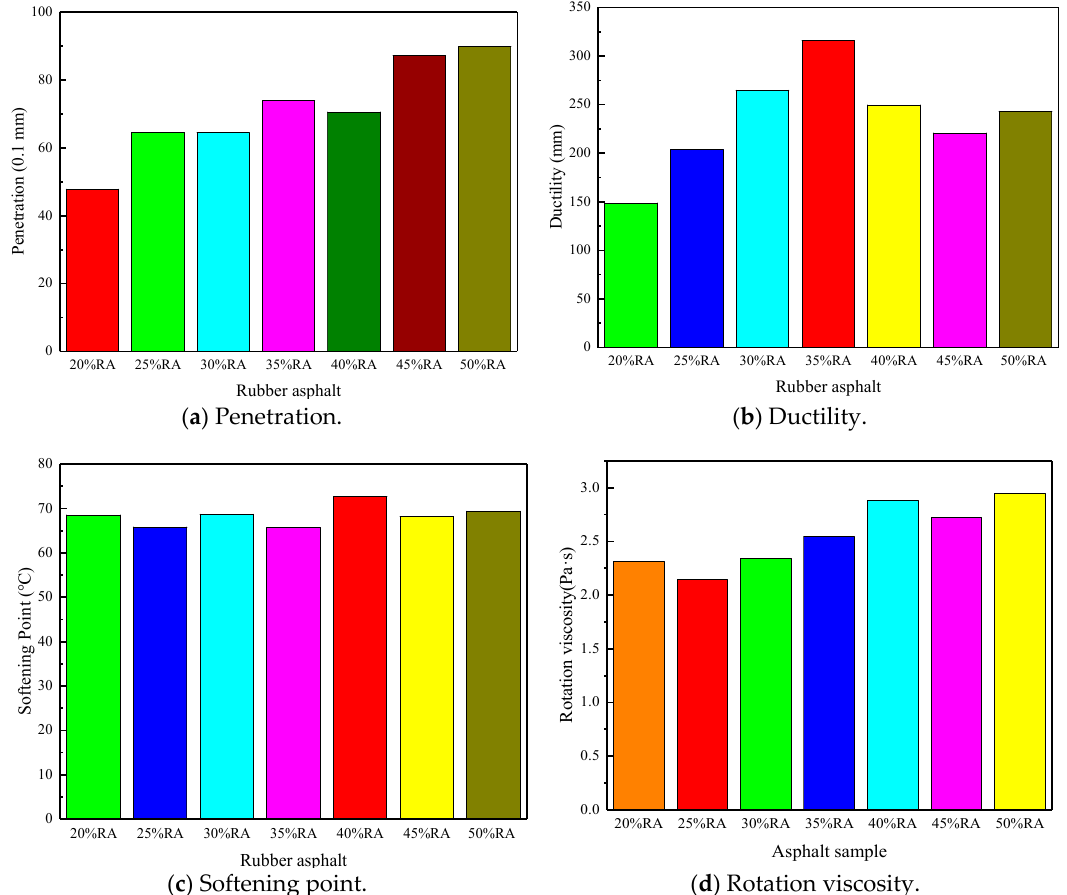
Figure 5. Penetration, ductility, softening point, and rotation viscosity.